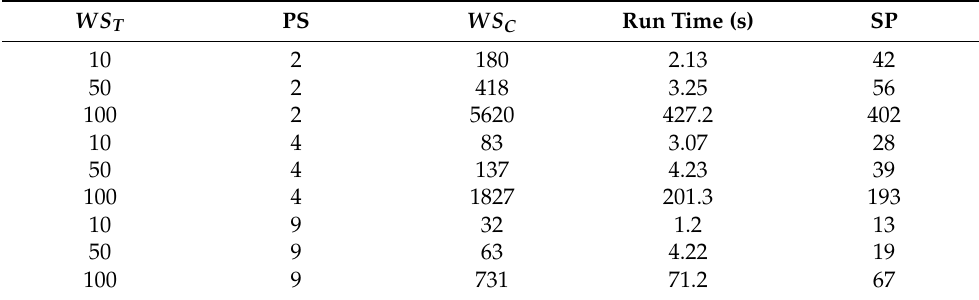
Table 3. Runtime results using PS.